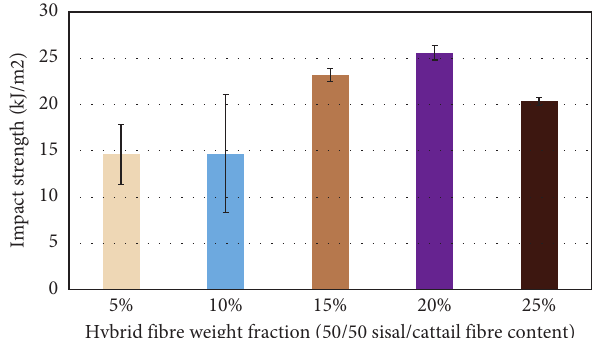
Figure 6: Impact strength of hybrid composites at a constant fibre blend ratio of 50/50 and varying hybrid fibre weight fraction.